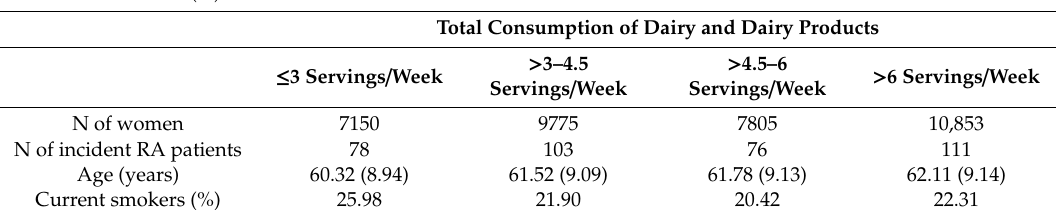
Table 2. Consumption of meat and meat products in 1997 and relative risk of developing rheumatoid arthritis among women in the Swedish Mammography Cohort during a 12 year follow-up